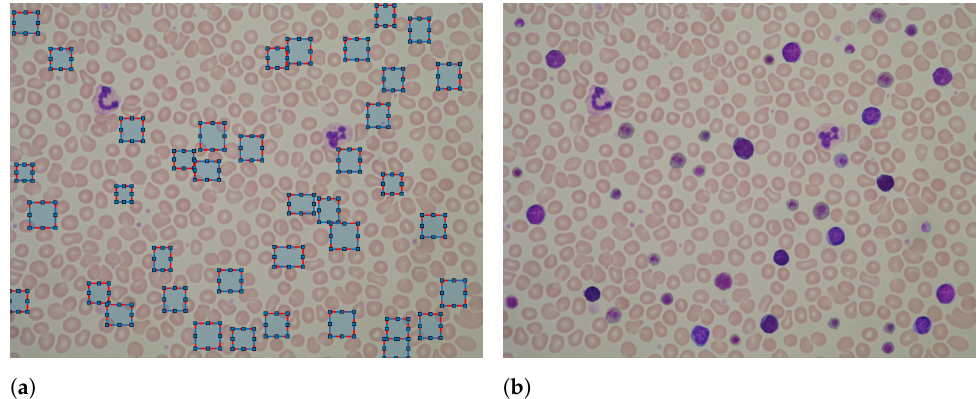
Figure 3. Example of synthetic image creation process. ( a ) Original ALL-IDB1 images and the BB manually selected as candidate positions for applying other leukocytes. ( b ) Synthetic image was created by exploiting the previous BB and the healthy WBC belonging to